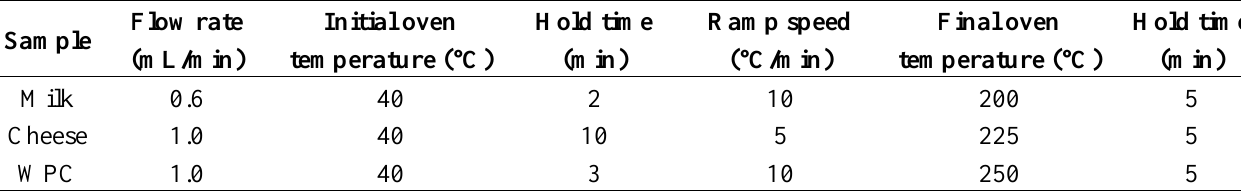
Table 1. Carrier gas and oven temperature programming for milk, Queso Fresco cheese, and whey protein concentrate